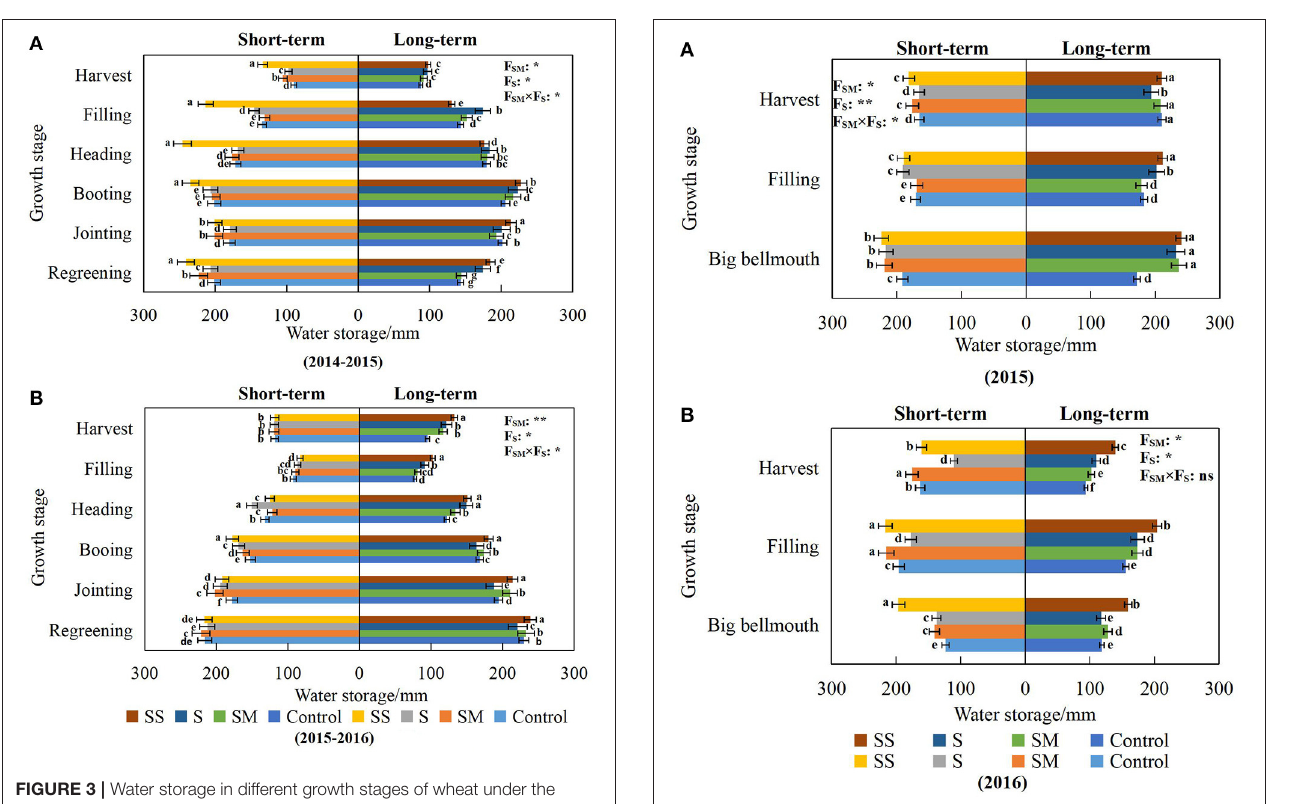
FIGURE 4 | Water storage in different growth stages of maize under the Control, SM, S and SS treatments in different years. Error bars represent standard deviation ( n = 3). Columns labeled with different letters represent significant differences at P < 0.05 among treatments of two experiments at same growth stage. (A) 2015 and (B) 2016. Control, conventional tillage; SM, straw mulching; S, subsoiling; SS, subsoiling + straw mulching. F SM , F S and F SM × F S mean F-values of straw mulching, subsoiling and their interactions in variance analysis respectively. “* and **” indicate difference at the 0.05 and 0.01 probability levels,